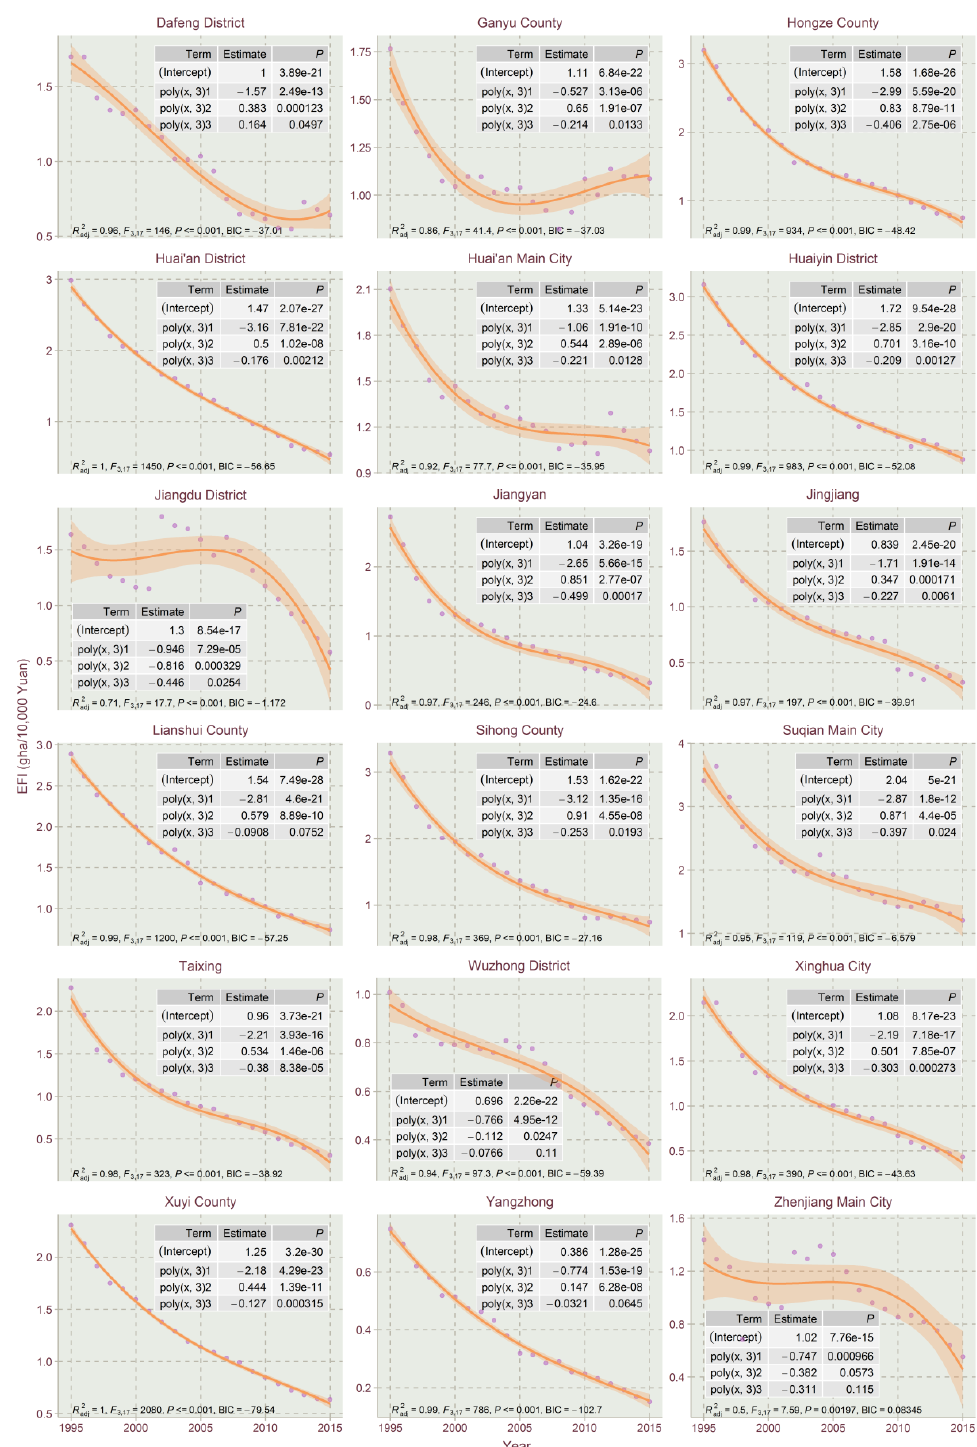
Figure 8. Cubic orthogonal curve fitting of EFIs of Jiangsu Province for 1995–2015 (Part 2).